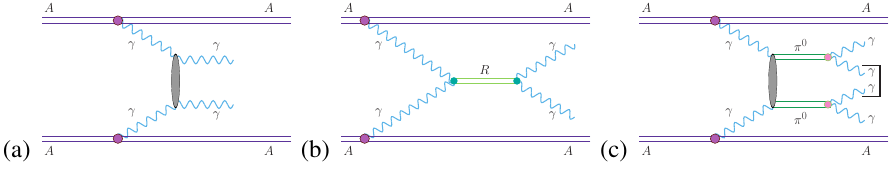
Figure 4. Diagrams for nuclear AA → AA γγ mechanism. Di ff erent subprocesses can be